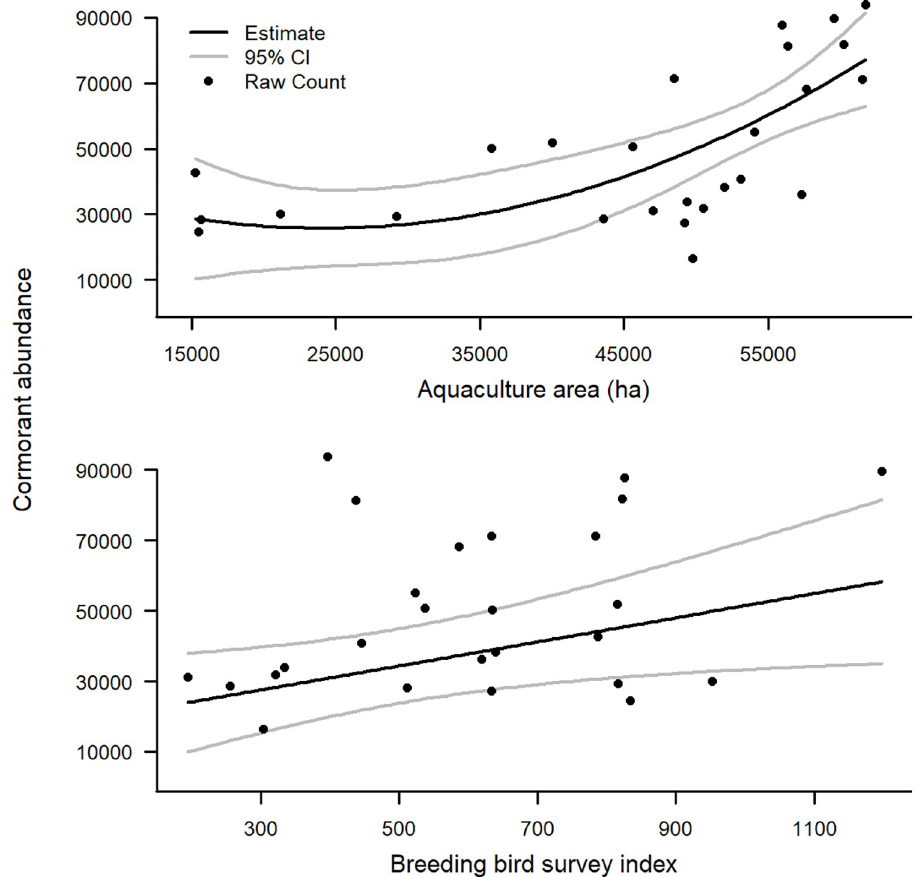
Fig 7. Modeled relationship (+ 95% CI) of total aquaculture area in the Mississippi Delta and breeding bird survey index on the maximum observed cormorant abundance within the Mississippi Delta. Estimates were made using linear regression by modeling yearly maximum cormorant abundance against both predictor variables, from 1989– 2010, 2012, and 2015–2017. Top ranked model included aquaculture area as a quadratic term and breeding bird survey index as a linear